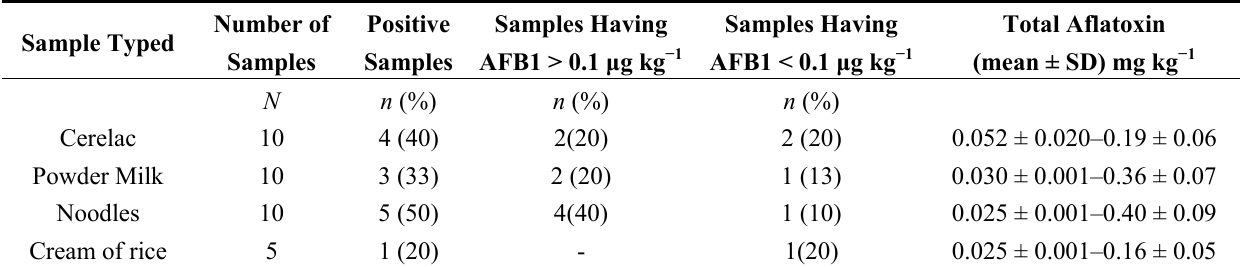
Table 2. Level of AFB1 and total aflatoxin (AFT) in processed food intended for